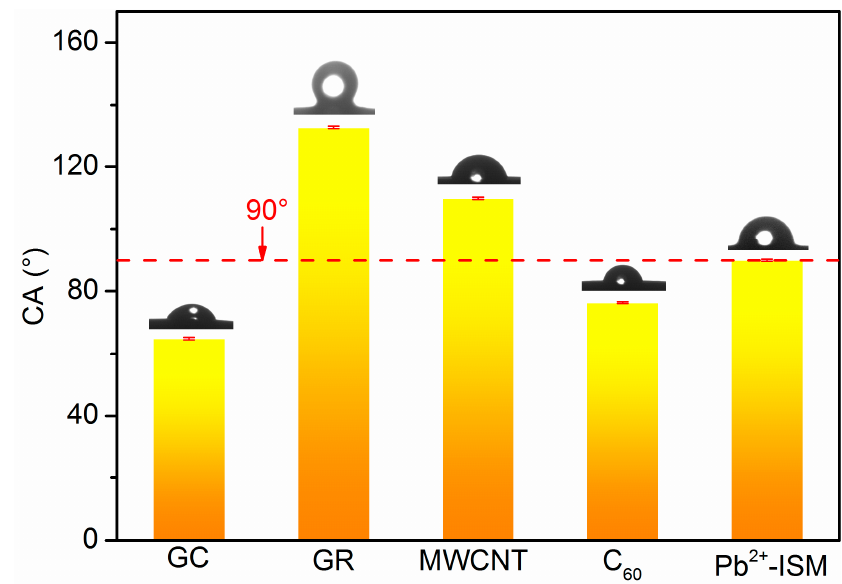
Figure 3. Contact angle (CA) of different carbon ‐ based nanomaterials intermediate layer.